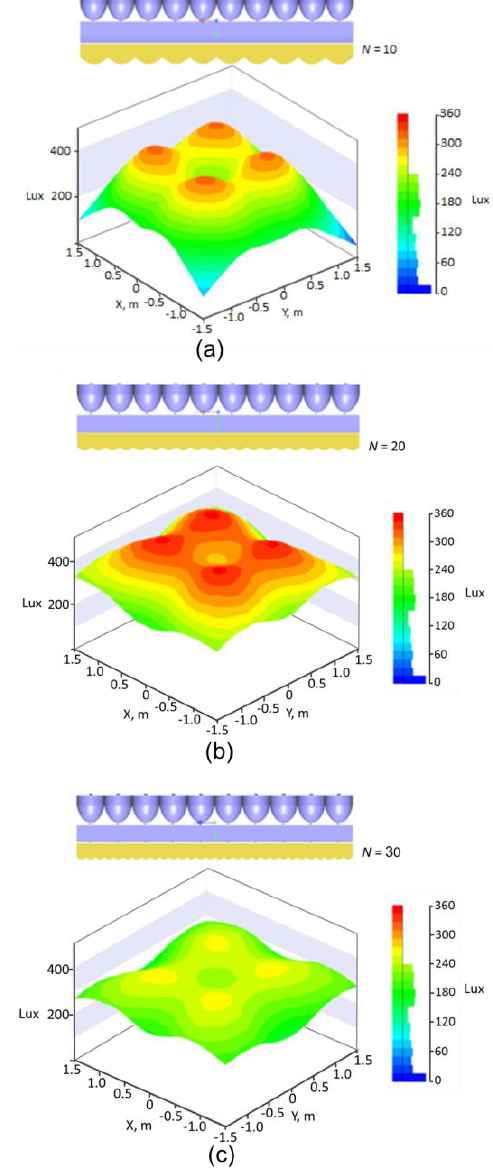
Figure 9. Light distribution on a receiver with ( a ) N = 10, ( b ) N = 20 and ( c ) N = 30.